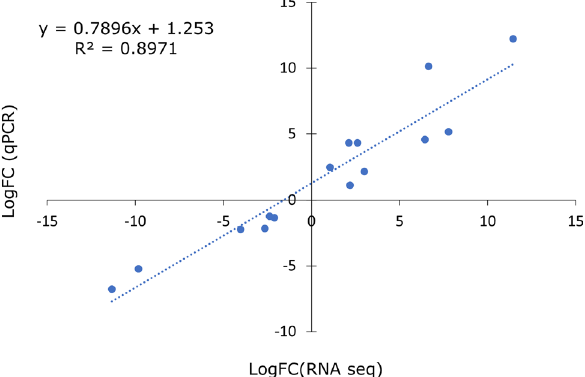
Figure 6. Correlation analysis of selected DEGs compared to the FC values from the qPCR independent assay with the representative R 2